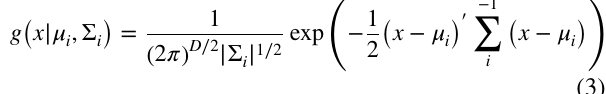
1 Density-based spatial clustering of applications with noise. 2 Balanced iterative reducing and clustering using